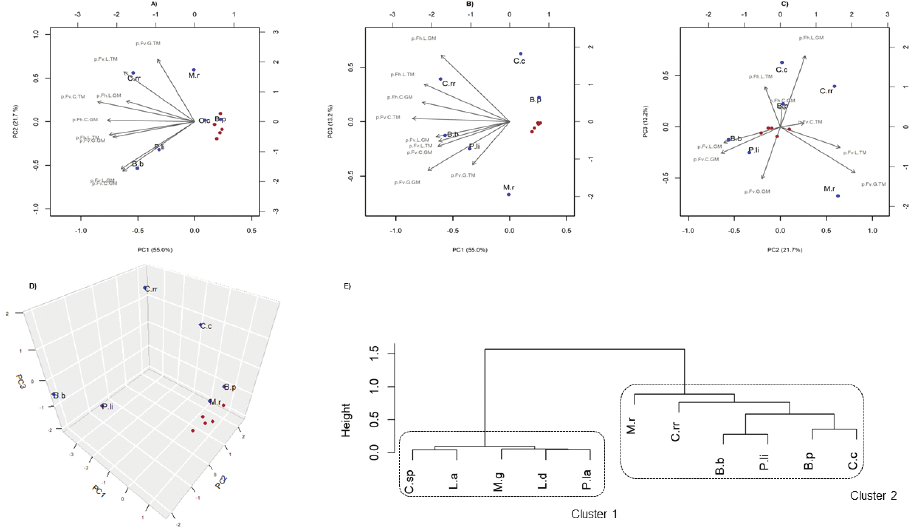
Figure 3. Principal component analysis (PCA) and hierarchical clustering of the observations based on the fungal isolations. a PC1 vs. PC2. b PC1 vs. PC3. c PC2 vs. PC3. d PCA 3D plot e Hierarchical clustering dendrogram to access the ecological proximities of obtained fungi based on their respective isolation profiles. Software R 4.3.2 was used to obtain the PCA plots and the hierarchical clustering. There was no fungal isola- tion from hedgerows from the farm Granja when bait-insect T. molitor was used and hence, it could not be included in any of the analysis which relies on proportions, i.e. PCA plots, hierarchical clustering. To reduce any bias, the authors also discarded the soil samples ( N =1) which yielded the fungal isolations, when G. mel- lonella was used, from the hedgerows of the farm Granja. The blue balls represent relatively more frequent EPF, i.e. Beauveria bassiana , Beauveria pseudobassiana , Clonostachys rosea f. rosea , Cordyceps cicadae , Purpureo- cillium lilacinum and Metarhizium robertsii . The red balls represent other fungi such as Cordyceps sp., Lecani- cillium aphanocladii , Lecanicillium dimorphum , Metarhizium guizhouense and Purpureocillium lavendulum . Hierarchical clustering based dendrogram classified isolated EPF into two clusters, i.e. rarely occurring EPF (cluster 1) and relatively more frequent EPF (cluster 2). Abbreviations used are: Beauveria bassiana (B.b), Beauveria pseudobassiana (B.p), Cordyceps cicadae (C.c), Cordyceps sp. (C.sp), Lecanicillium aphanocladii (L.a), Lecanicillium dimorphum (L.d), Metarhizium guizhouense (M.g), Purpureocillium lavendulum (P.la), Purpureocillium lilacinum (P.l), Clonostachys rosea f. rosea (C.rr) and Metarhizium robertsii